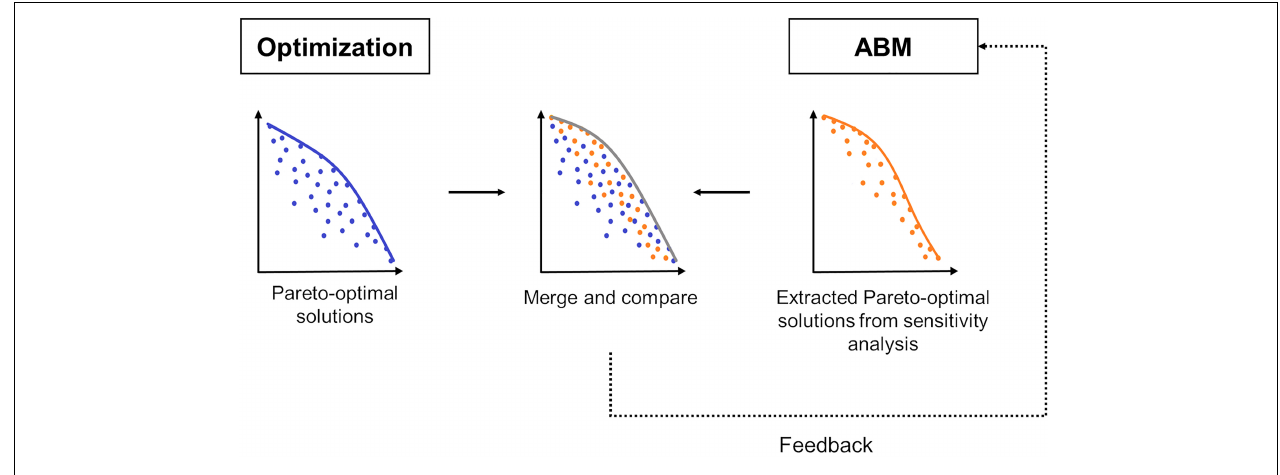
FIGURE 1 | Illustration of the conceptual framework aligning agent-based modeling with multi-objective land-use allocation